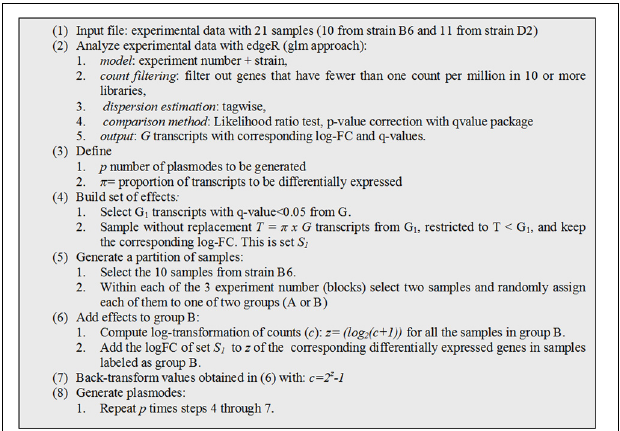
FIGURE 4 | Algorithm used to generate plasmode datasets with differentially expressed transcripts under a model with two classification variables (block +